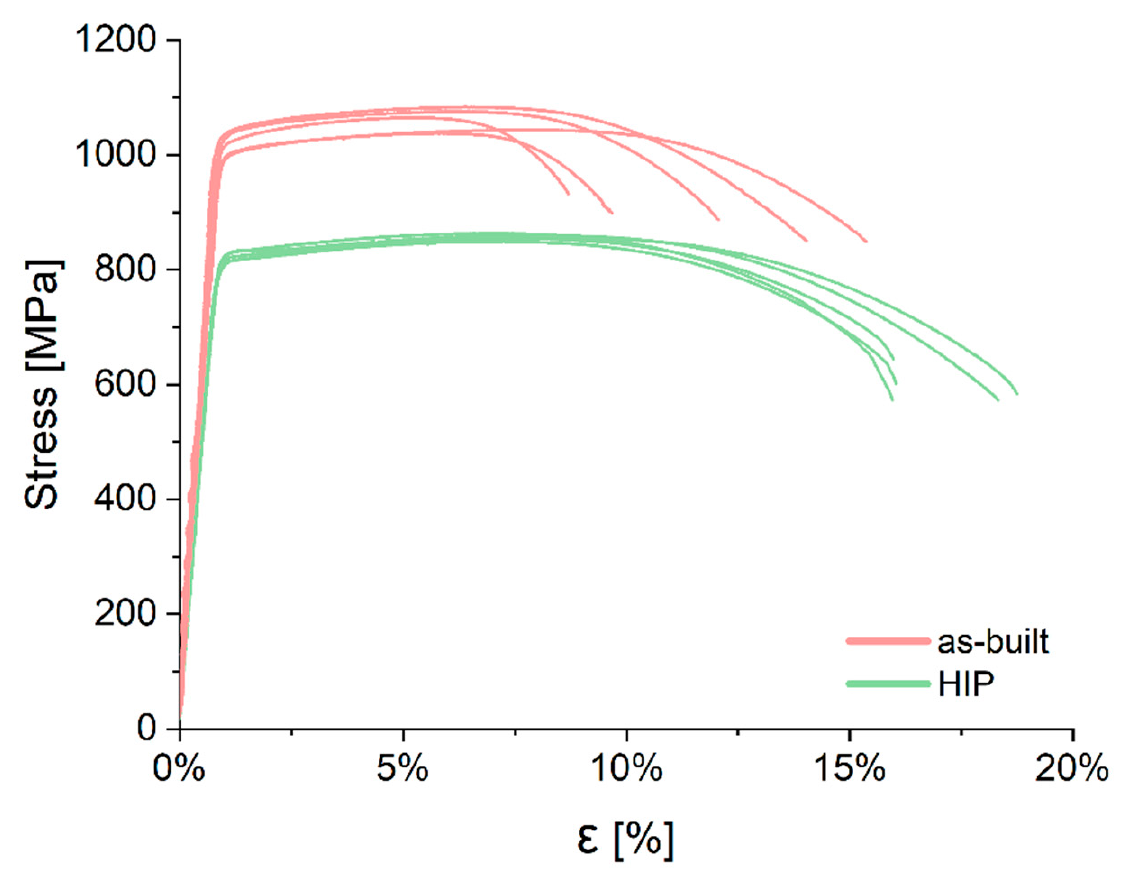
Figure 11. Tensile curves, comparison between the as-built and HIP specimens.